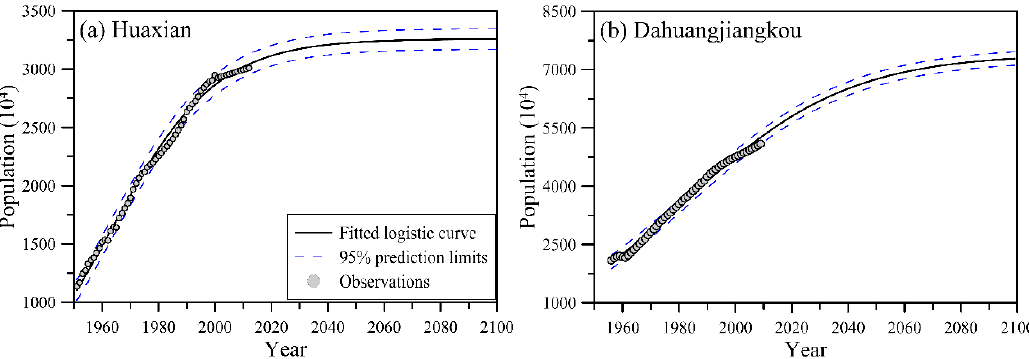
Figure 6. Logistic population growth curves of ( a ) the Huaxian station for the period of 1951–2099 and ( b ) the Dahuangjiangkou station for the period of 1956–2099.